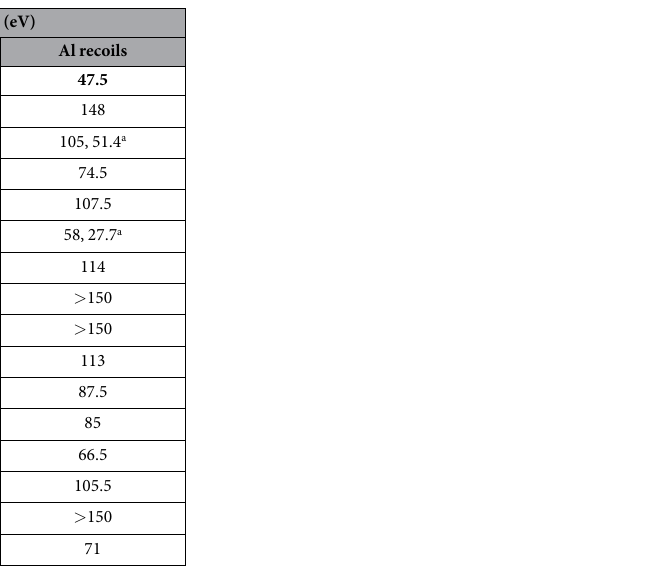
Table 2. Threshold displacement energies (E d ) for O and Al recoils. The minimum values for O and Al PKAs are indicated in bold. a Ref.